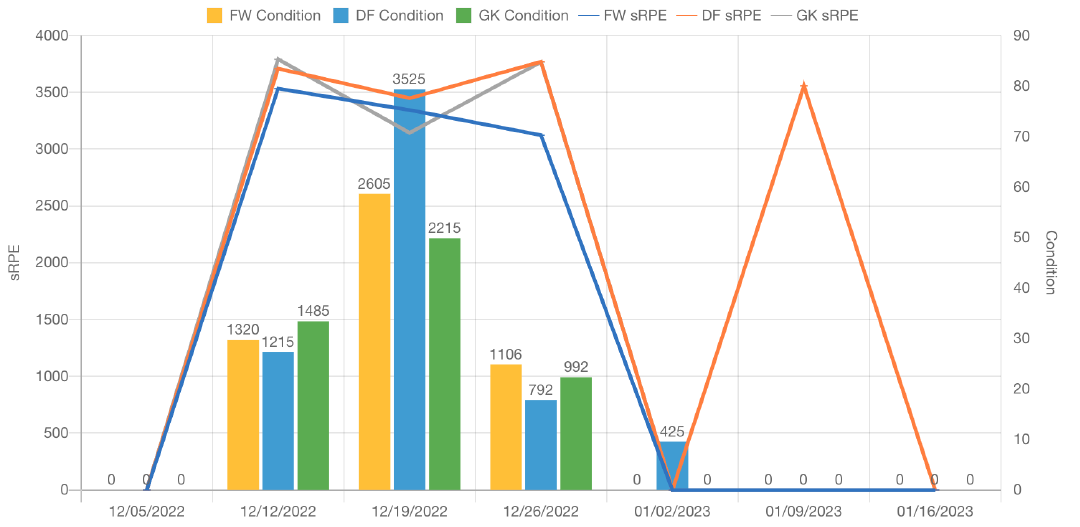
Figure 6. Weekly sRPE, ACWR,